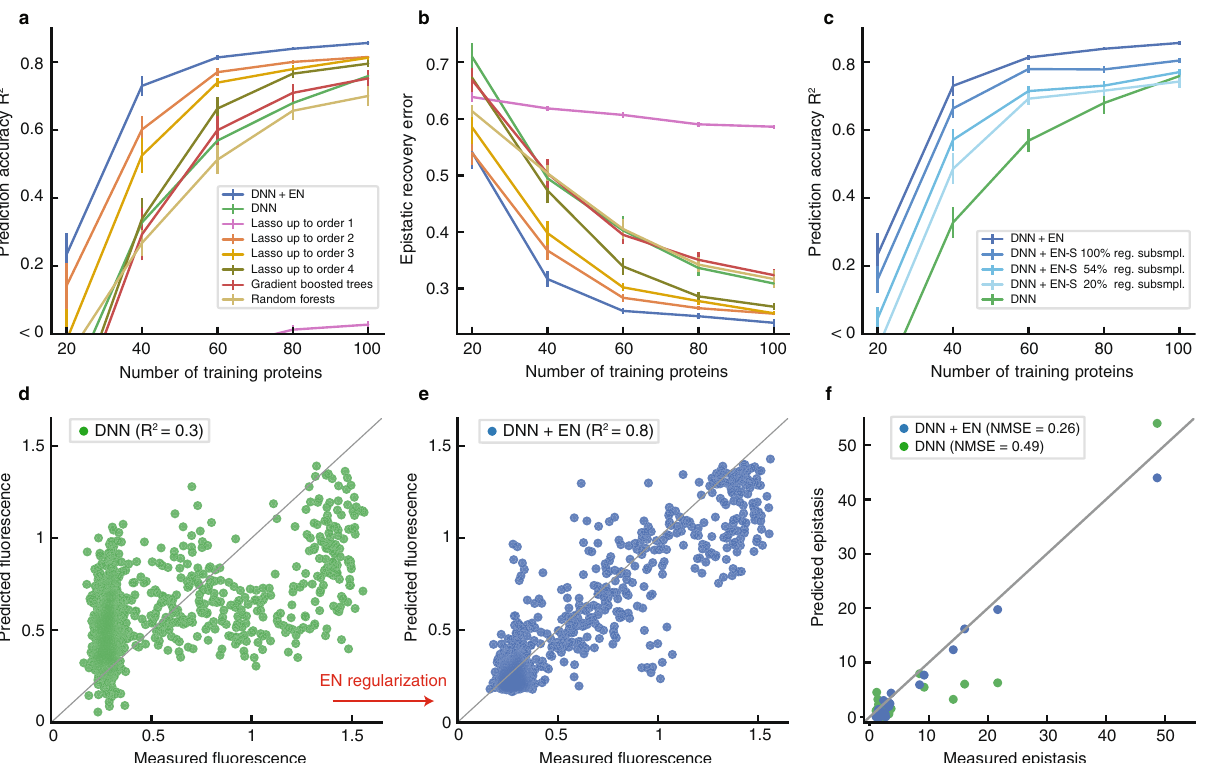
Fig. 3 Inferring the sparse epistatic protein landscape of Poelwijk et al. 3 . a Deep neural network (DNN) with Epistatic Net (EN) regularization outperforms the baselines in terms of prediction accuracy. To achieve the same prediction accuracy, DNN with EN regularization needs up to 3 times less number of samples compared to DNN without EN regularization. b DNN with EN regularization recovers the experimentally measured (higher-order) epistatic interactions with signi fi cantly lower normalized mean squared error (NMSE). c The prediction performance of DNN with EN-S regularization is plotted when EN-S subsamples DNN at progressively smaller fractions of the combinatorial sequence space of proteins, that is, 100% (no subsampling), 54%, and 20%. DNN with EN-S regularization outperforms DNN without the regularization despite restricting EN-S to only sample 20% of the protein sequence space to induce a sparse-graph code. Error bars in all the plots show the standard error of the mean (SEM) in 20 independent repeats of the experiments with random splits of the data into training, validation, and test sets. d Scatter plot of the DNN-predicted fl uorescence values trained on n = 60 labeled proteins. e Scatter plot of the predicted fl uorescence values by the EN-regularized variant of the same DNN. f Comparison of the recovered epistatic interactions of the EN-regularized and unregularized